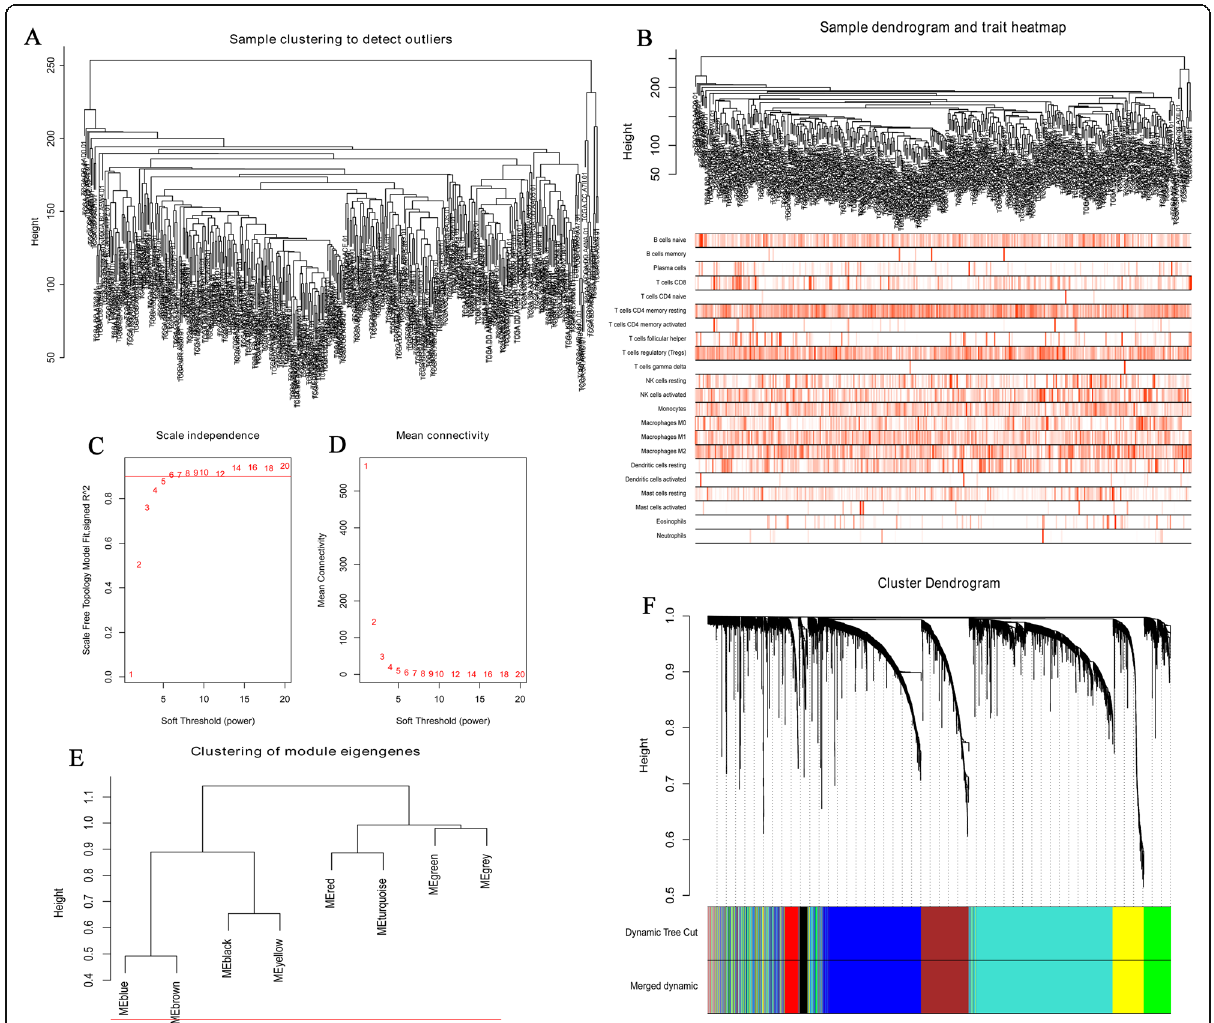
Fig. 2 Cluster analysis and construction of WGCNA. A Sample clustering. B Sample dendrogram and trait heatmap. In the heatmap, the darker the color, the higher the degree of cell infiltration. C The scale-free fitting index of different soft threshold power ( β ). D The average connectivity of various soft threshold powers. E The horizontal line indicates the module merge threshold. F Clustering results of modules in gene data in WGCNA analysis. WGCNA: weighted gene co-expression network